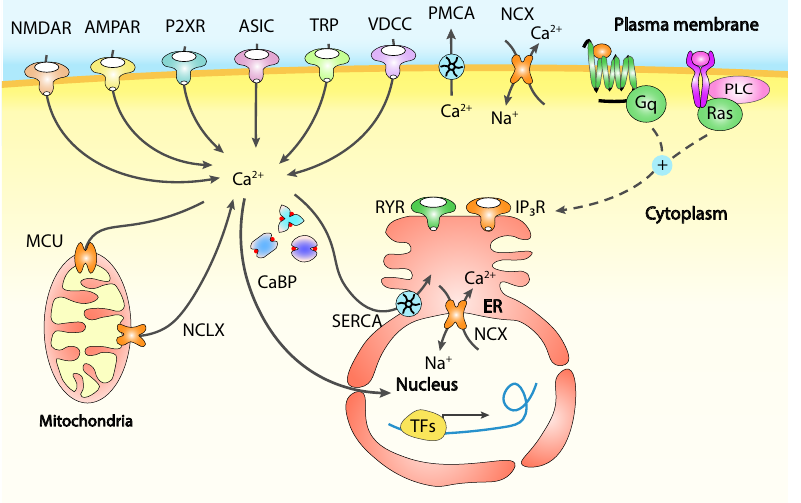
Figure 2. Calcium sources and sinks. Calcium can enter neurons from the extracellular space through many membrane channels as NMDARs and AMPARs, P2XRs, ASICs, TRP channels and VDCCs while PMCA pumps and NCX Ca 2+ exchanger extrude calcium to the extracellular environment to maintain the basal membrane potential and regulating the intracellular calcium